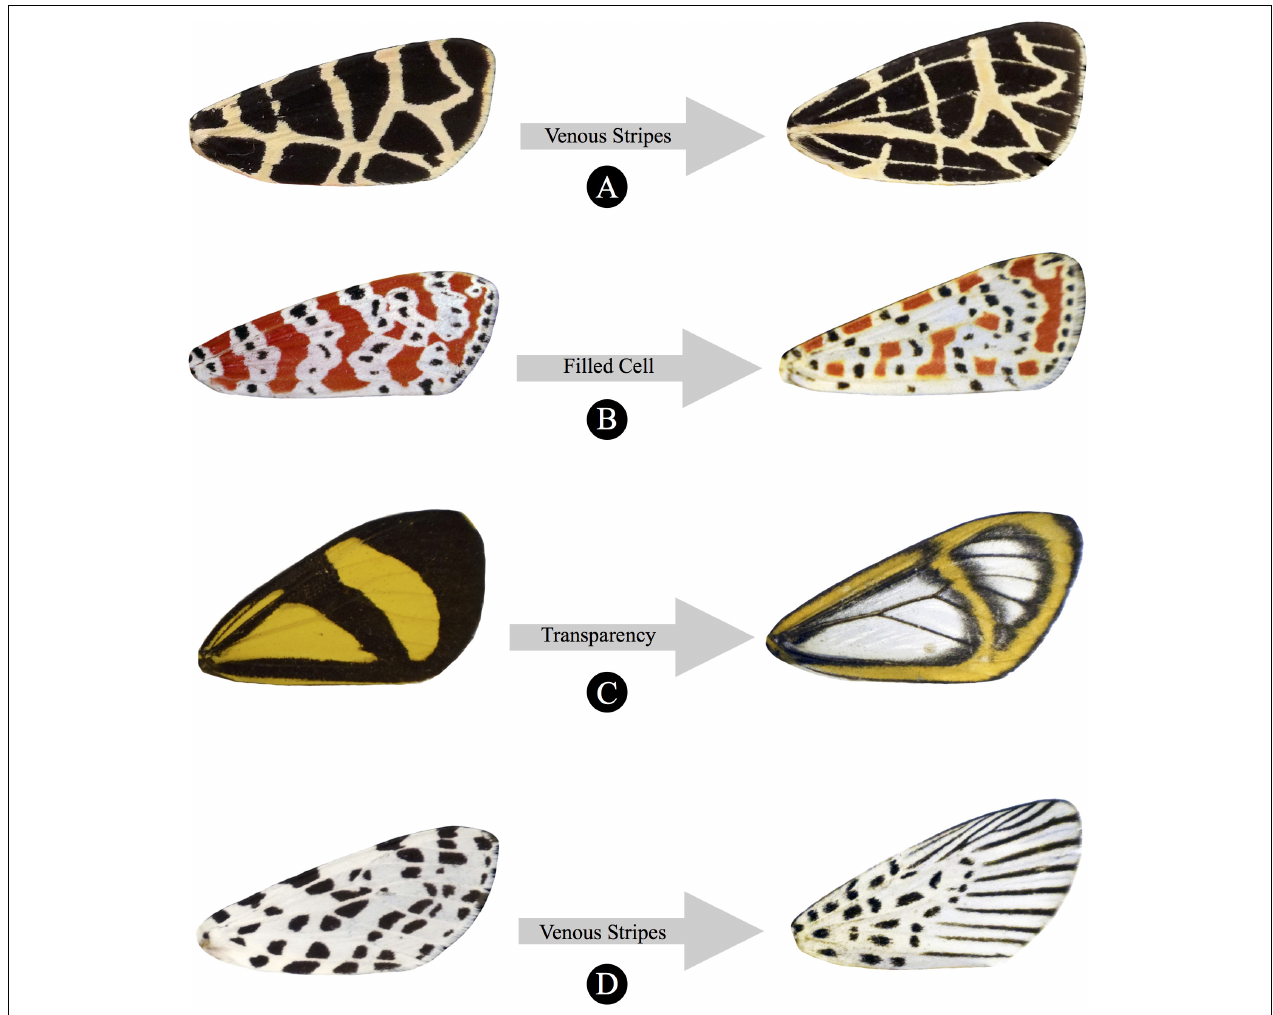
FIGURE 8 | The diversity observed in tiger moth wing patterns is not attributable solely to changes in the size, shape, and position of the five archetypical characters. Detailed elements can be added to dorsal forewing patterns, and their inclusion often radically changes its appearance. Row (A) shows how the inclusion of overlaid venous stripes can alter pattern morphology (left: Apantesis nevadensis ; right: Apantesis ornata ). Row (B) illustrates how a filled discal wing cell can significantly alter a color pattern’s appearance (left: Utetheisa ornatrix ; right: Utetheisa pulchella ). As shown in row (C) , the replacement of various pattern features with transparency can be a source of pattern diversity (left: Ephestris melaxantha ; right: Hyalurga fenestra ). With H. fenestra , the black primary characters have become transparent, but in some wasp-mimicking species, it appears that the background coloration has been modified to become transparent. Finally, the animals shown in row (D) , demonstrate that the addition of venous stripes can change the overall structure and appearance of the pattern (left: Hypercompe permaculata ; right: Agrisius guttivitta